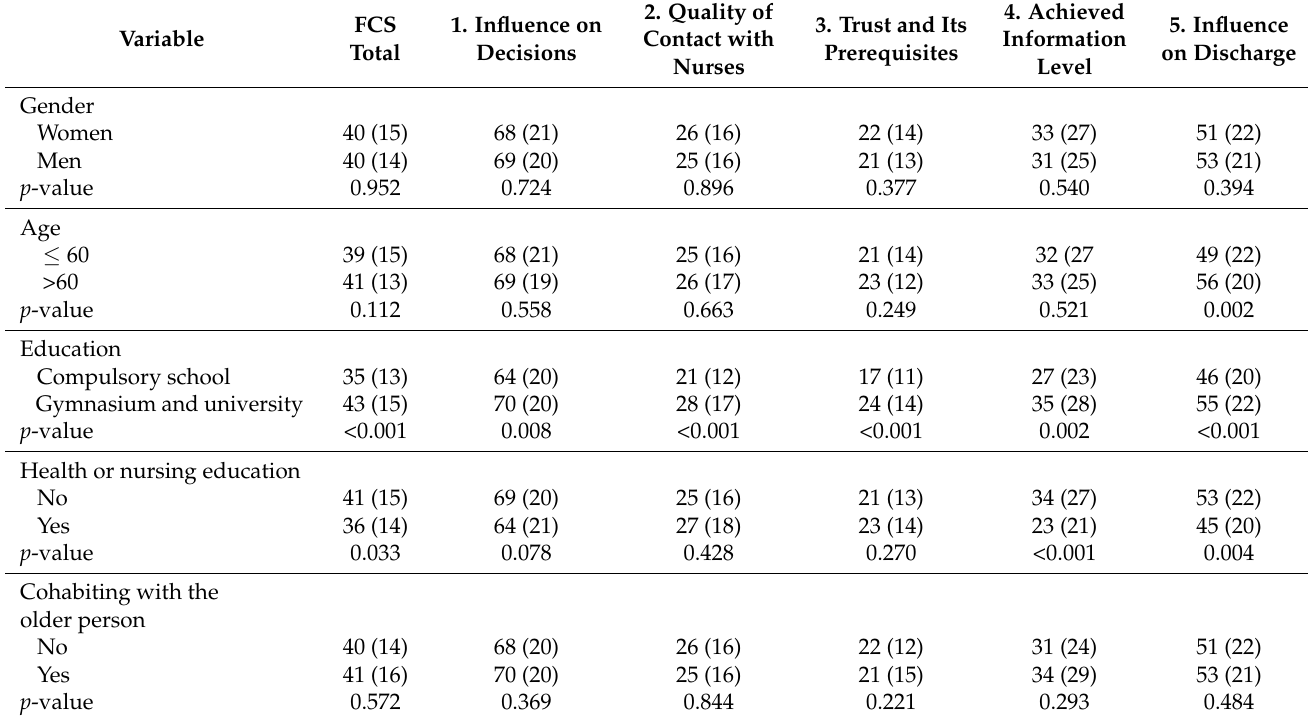
Table 3. Mean (standard deviation) of FCS total and subscales by responder’s characteristics.